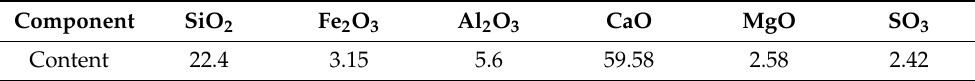
Table 1. Chemical composition of cement